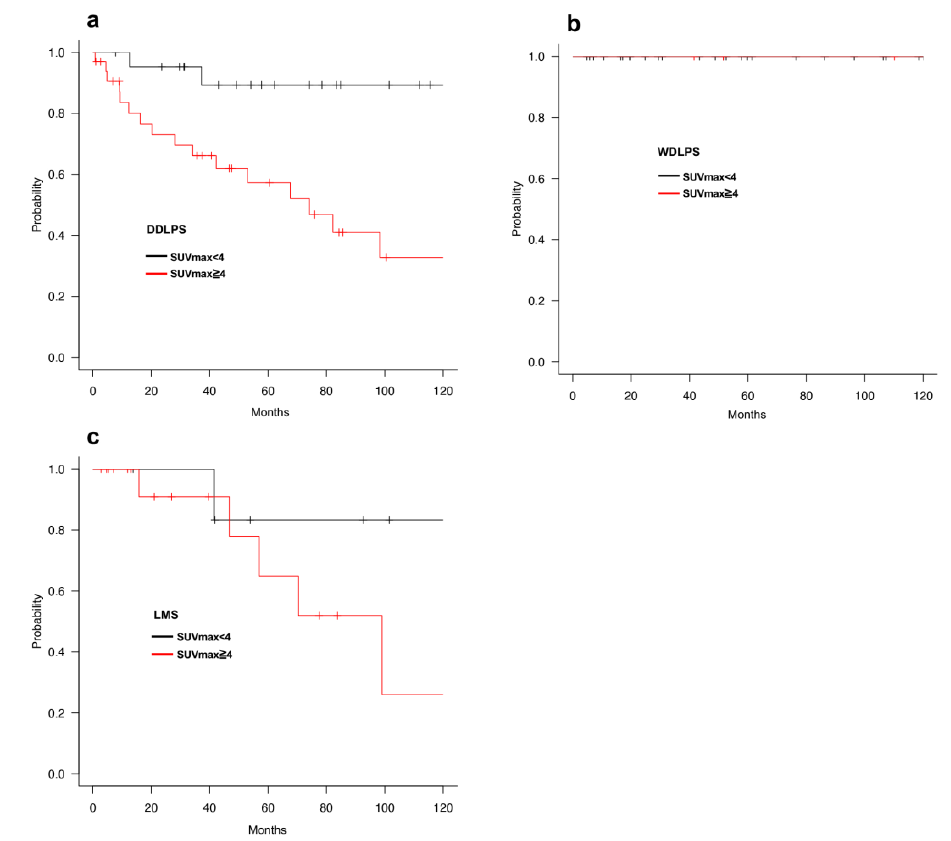
Figure 4. ( a – c ) OS of RPS patients with SUVmax low (<4) or SUVmax high ( ≥ 4) by histological subtypes, ( a ); DDLPS, ( b ); WDLPS and ( c ); LMS. Table 5. Analyses on survival in all DDLPS